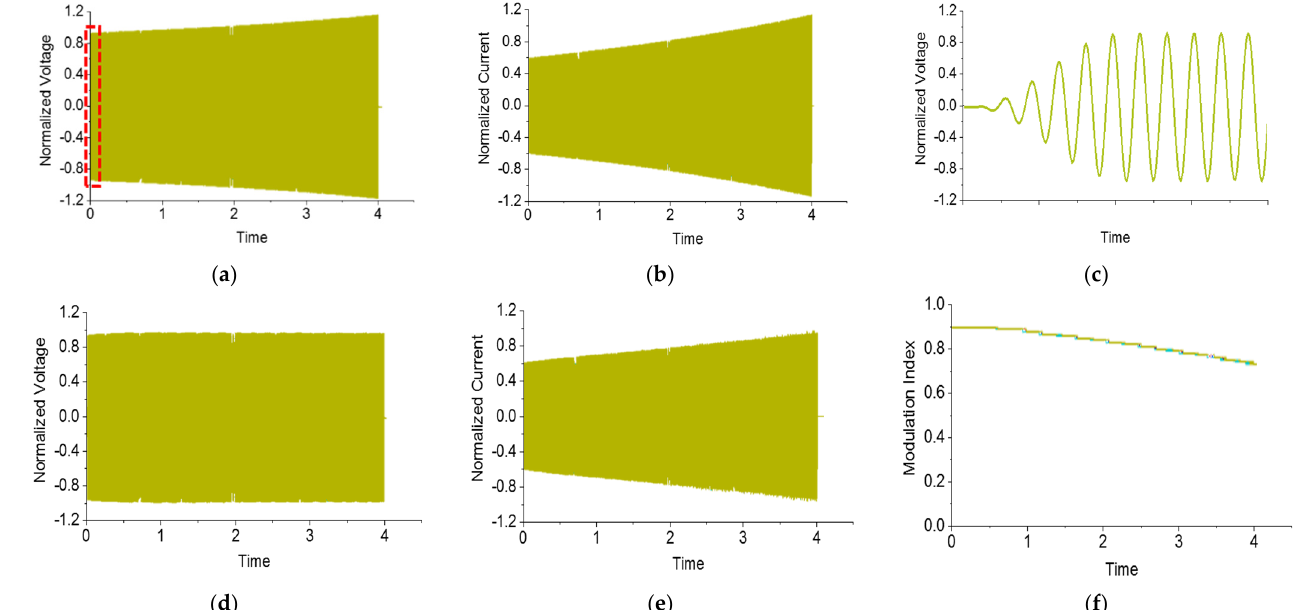
Figure 9. The output voltage and current with or without the CPVC in the simulated load: ( a ) the normalized output voltage without the control; ( b ) the normalized output current without the control; ( c ) the enlarged output voltage without the control; ( d ) the normalized output voltage with the CPVC; ( e ) the normalized output current with the CPVC; ( f ) the modulation index with the CPVC.